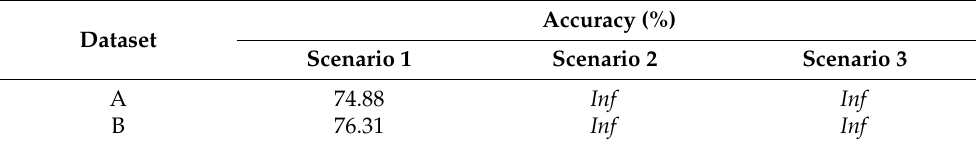
Table 11. Determinant of the variance-covariance matrix for datasets A and